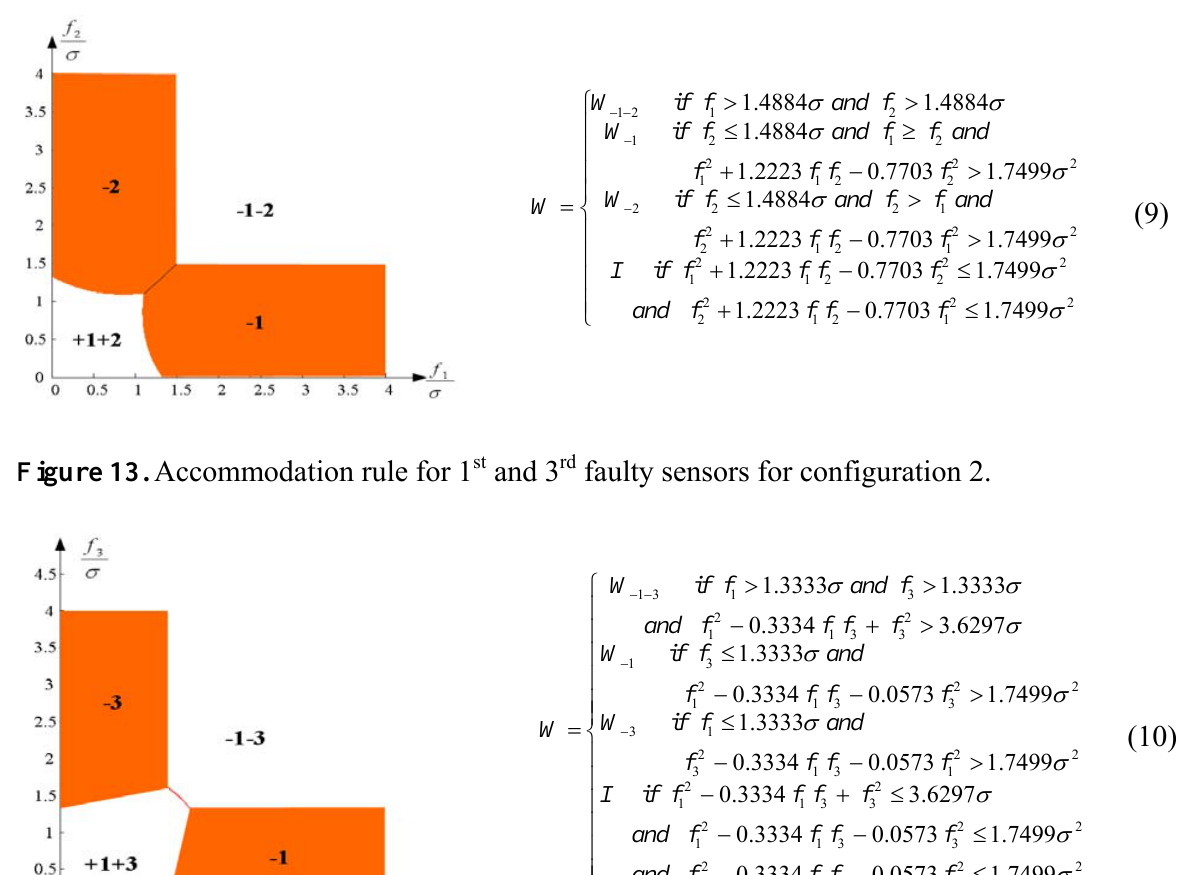
Figure 12. Accommodation rule for 1 st and 2 nd faulty sensors for configuration 2.